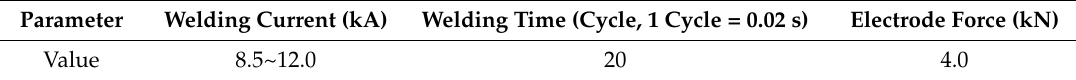
Figure 2. Schematic diagram of dimensions and configuration of resistance spot welding joint. Table 2. Experimental parameters.